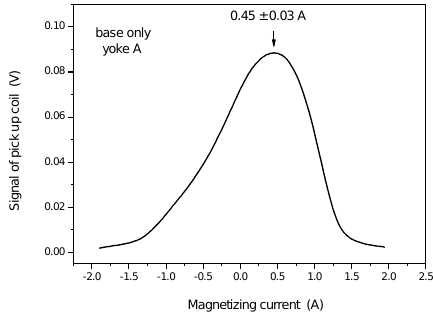
Figure 8. Signal of the pick-up coil as a function of the magnetizing current, measured on base material by applying Yoke A.